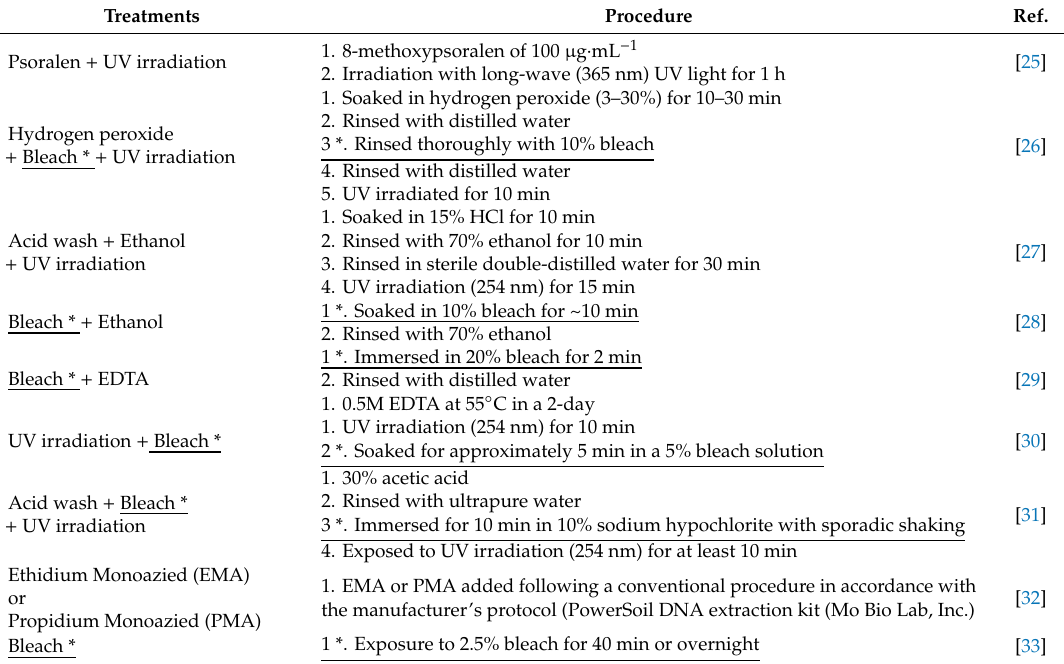
Table A1. Detailed previous treatment procedures in Table 1 (summary of previous treatment processes for decontamination in DNA analyses).